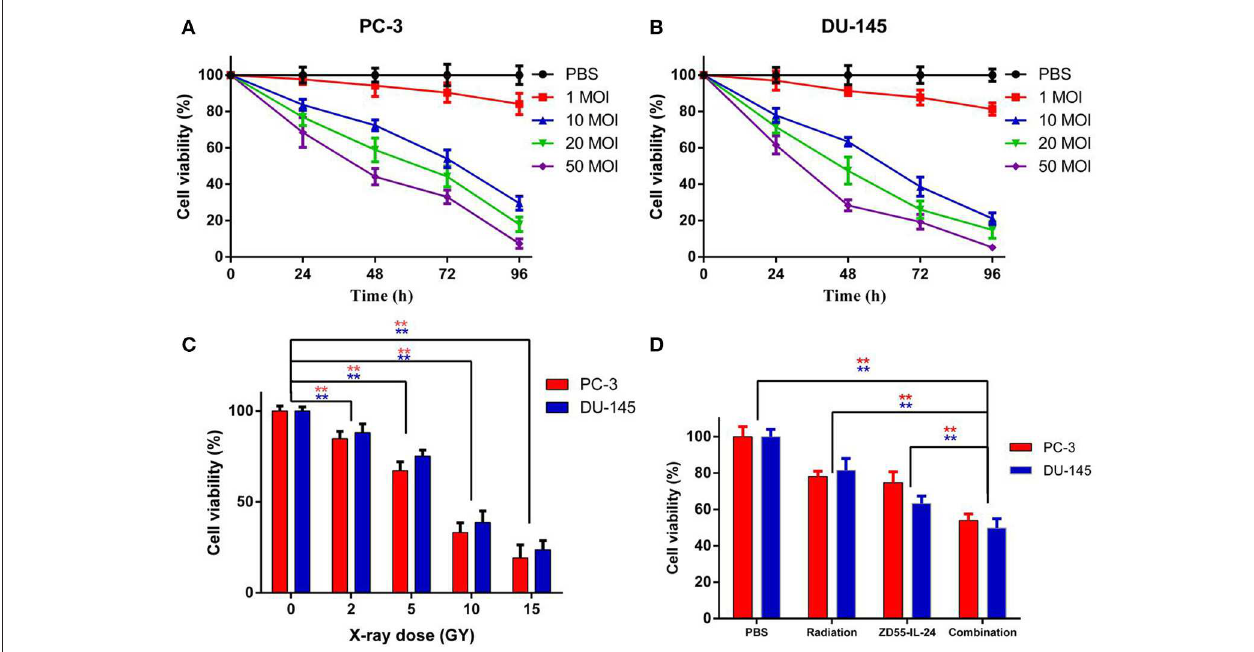
The data were analyzed by SPSS 16.0 and plotted by Graphpad Prism 6 software. Data were expressed as mean ± SD. The T